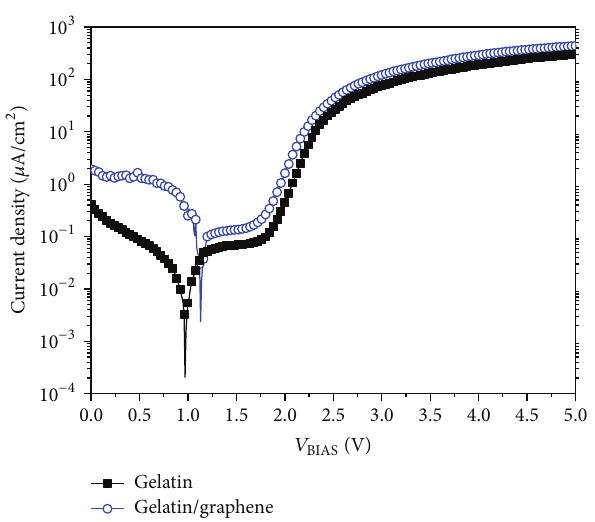
Figure 2: Comparison of the current density-voltage characteristics ofapuregelatinandagelatin/graphenesystematroomtemperature.